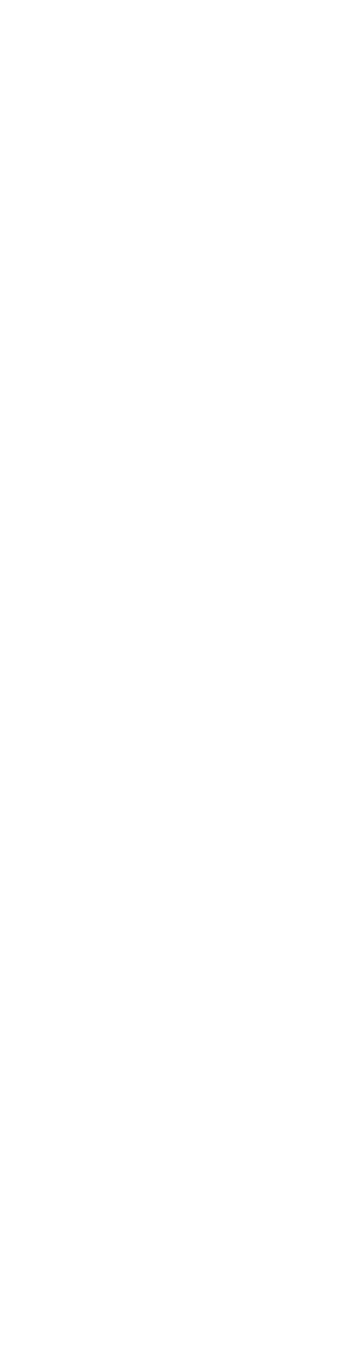
FIGURE 3 Vertical distributions of P. echinogaster eDNA along different longitude and latitude sections in the East China Sea. Figures (A – F) and (J – G) show the eDNA distribution for different latitudinal and longitudinal sections, respectively. Log-transformed eDNA concentration values are indicated by color gradients. The dark gray areas indicate the sea